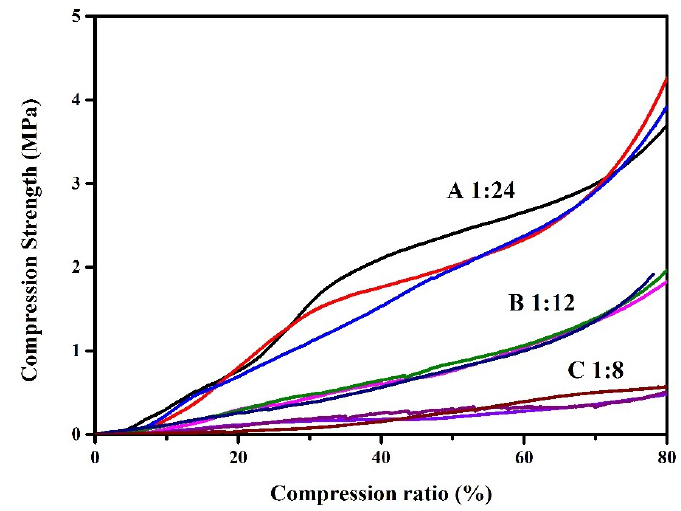
Figure 6. Compression strength of cryogels at 80% of the original height.